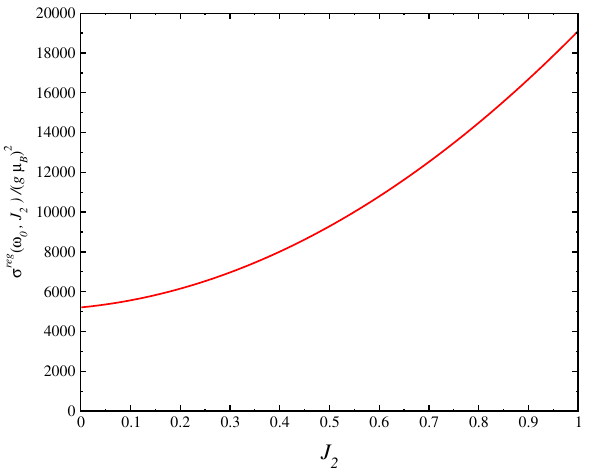
0.0 . We perform 0.1 , J 1.0 and J , z , y = = = − 2 should ⊥ ⊥ 0.03 . The factor ( g µ ω p B ) = ≈